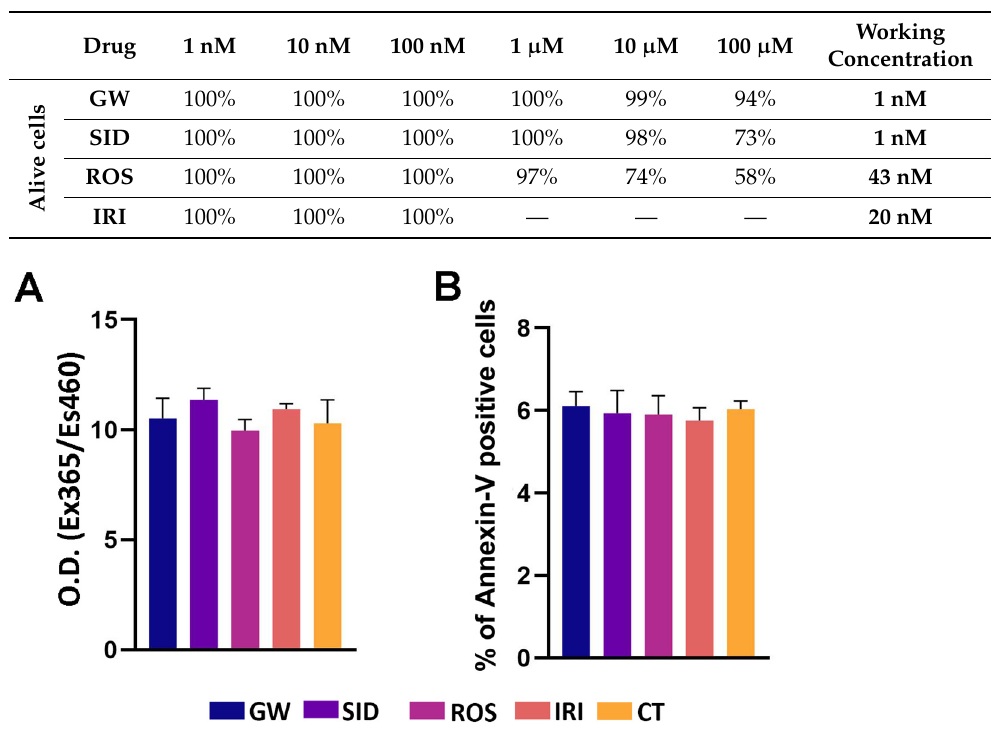
Table 1. Cell viability after 3 days of incubation with drugs, at different concentrations. For each drug, the last column indicates the concentration used in all the described experiments.